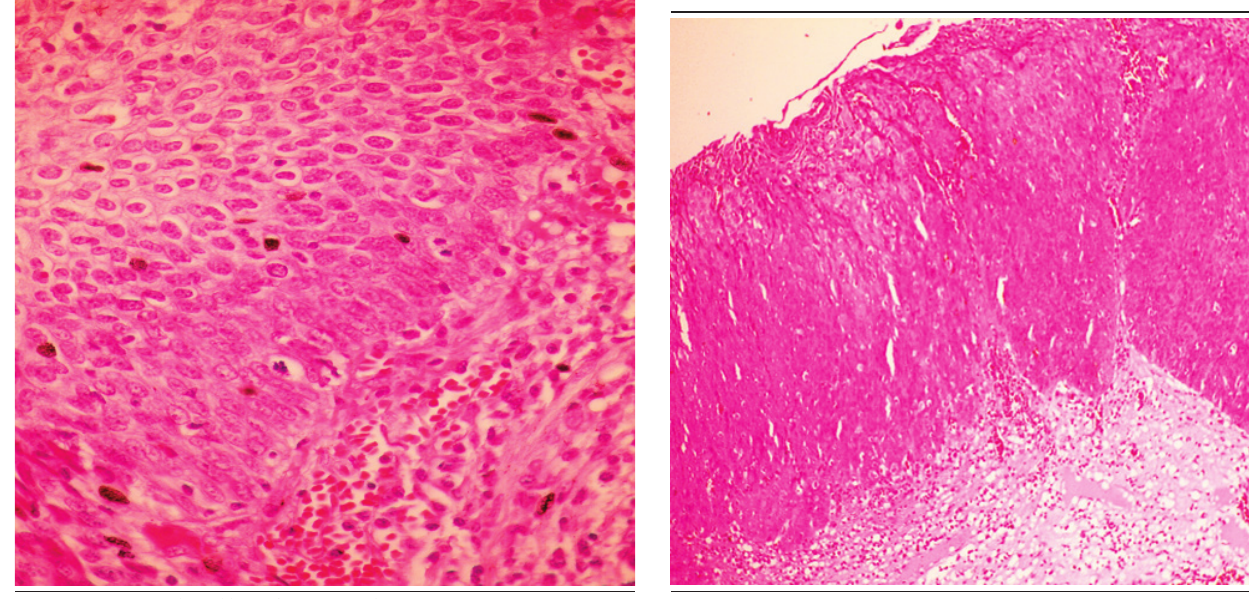
figuRE 5 − High-grade anal lesion (HE stain, 40×) Histological section of anal canal with immature cells occupying more than the lower two- thirds of the epithelium with a thin layer of atypical maturating cells on the surface. HE: hematoxylin and